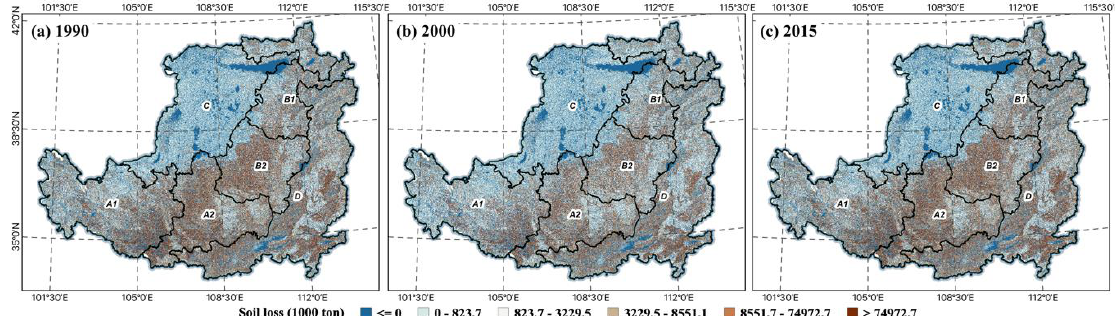
Figure 5. Soil loss change in the LP, 1990 ( a ), 2000 ( b ), 2015 ( c ).